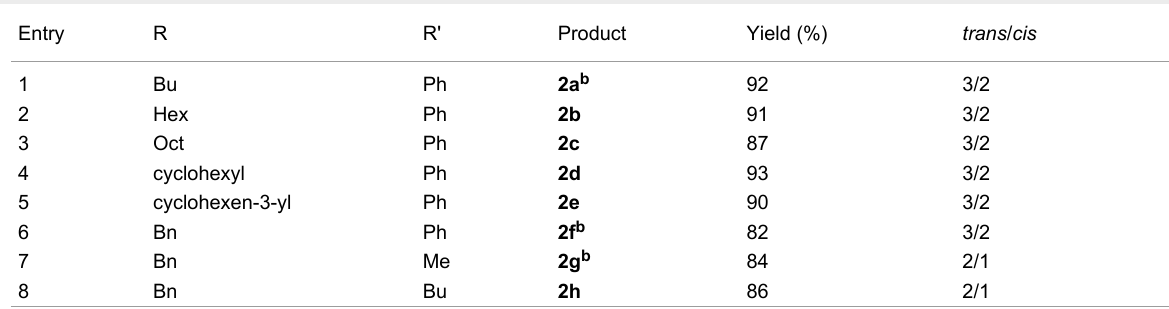
Table 1: Results of 3-substituted phospholanes a